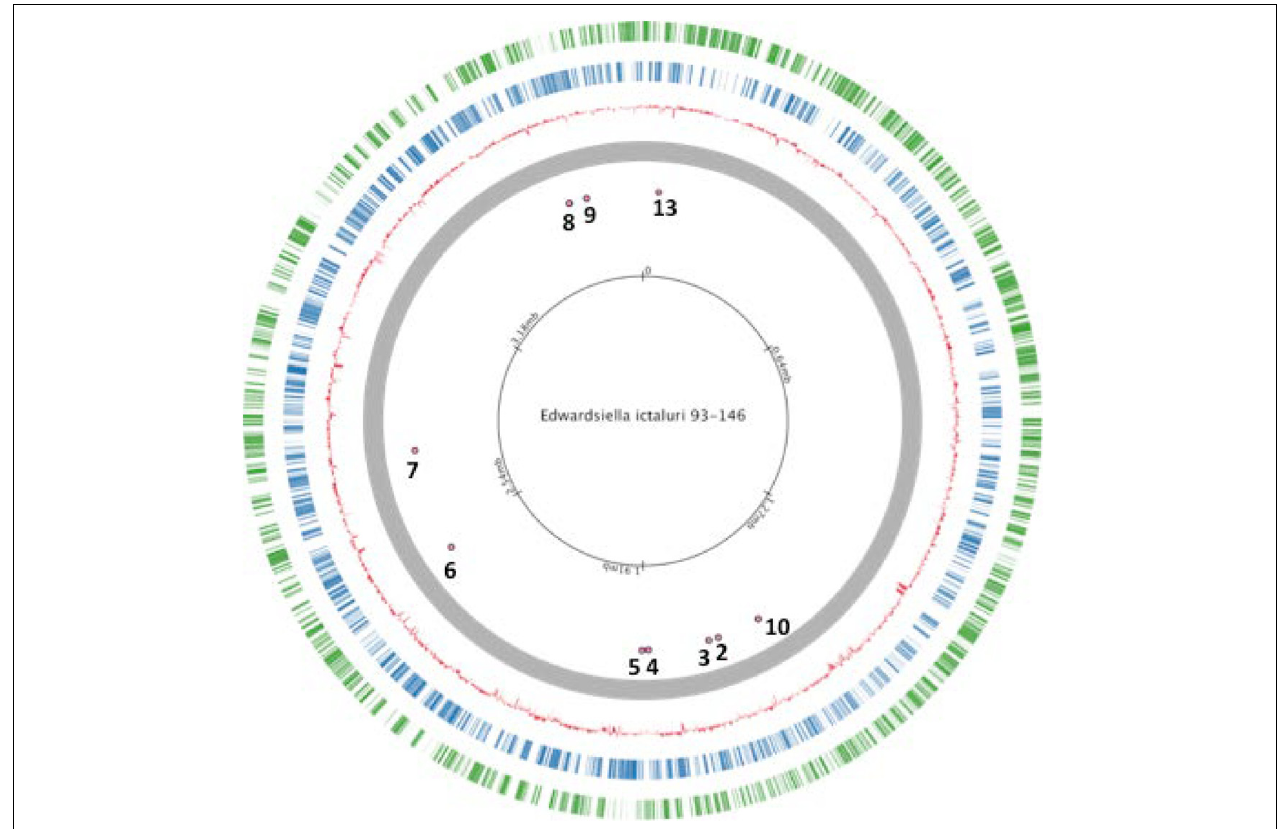
FIGURE 1 | Locations of studied universal stress proteins in Edwardsiella ictaluri strain 93–146 genome.